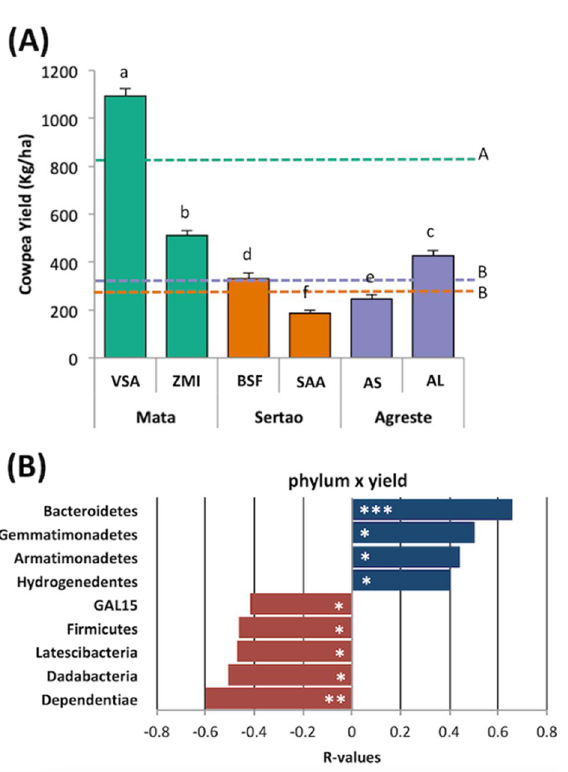
Figure 3. ( A ) Heatmap showing the Spearman’s rank correlation coefficients and statistical significance between phyla abundance and soil chemical parameters. Blue and red colors indicate significant positive and negative correlations, respectively ( P < 0.05). ( B ) Spearman correlation between bacterial diversity and soil chemical parameters ( P < 0.05). SB: sum of basis, V (%): basis saturation, m (%) Al 3+ saturation. Heatmap constructed using the R package ‘corrplot’.